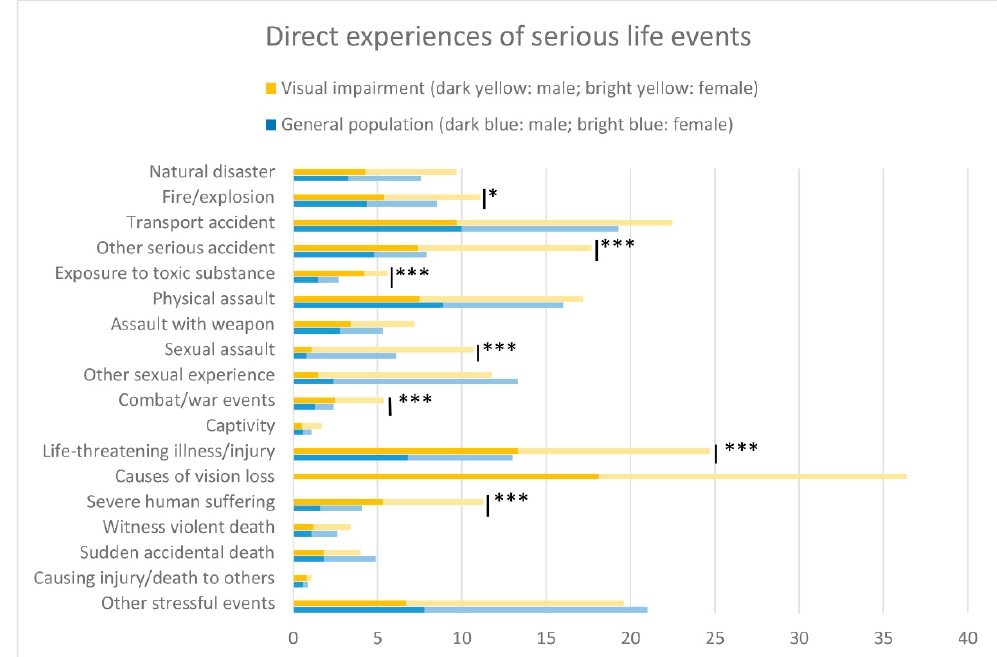
Figure 1. Direct exposure to serious life events in people with visual impairment ( N = 736) compared with the general population ( N = 1792). * p < 0.05, *** p < 0.001.